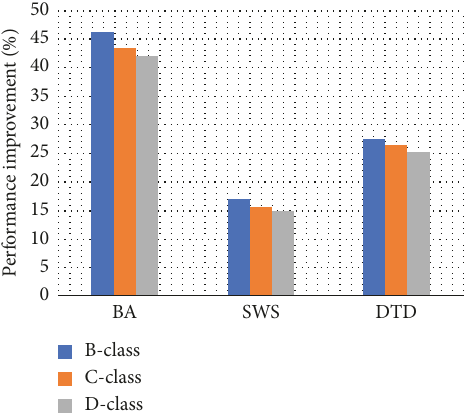
Figure 12: Performance improvement at different vehicle Table 5: Self-supply energy efficiency under different roads.